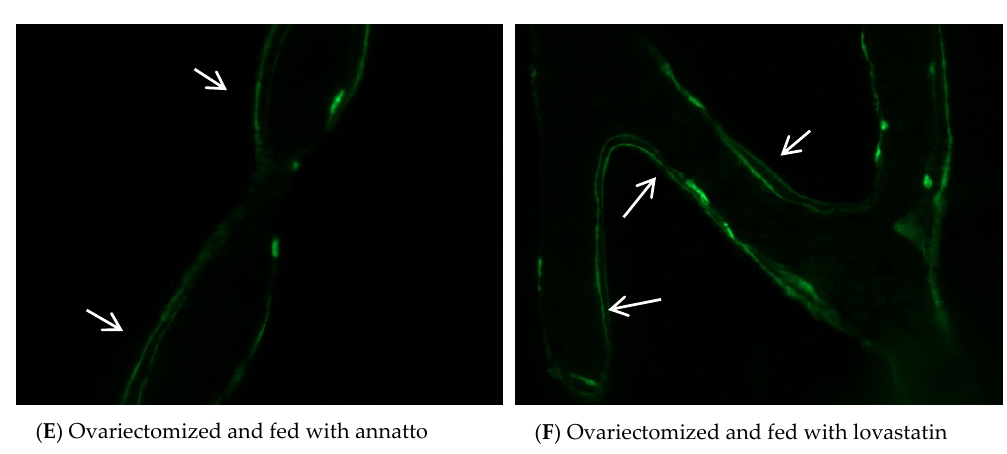
Figure 1. Micrograph of calcein-labeled trabecular bone. Rats treated with annatto tocotrienol alone or in combination with statin showed more calcein double-labeled surface. The white arrows show double-labeled surface.